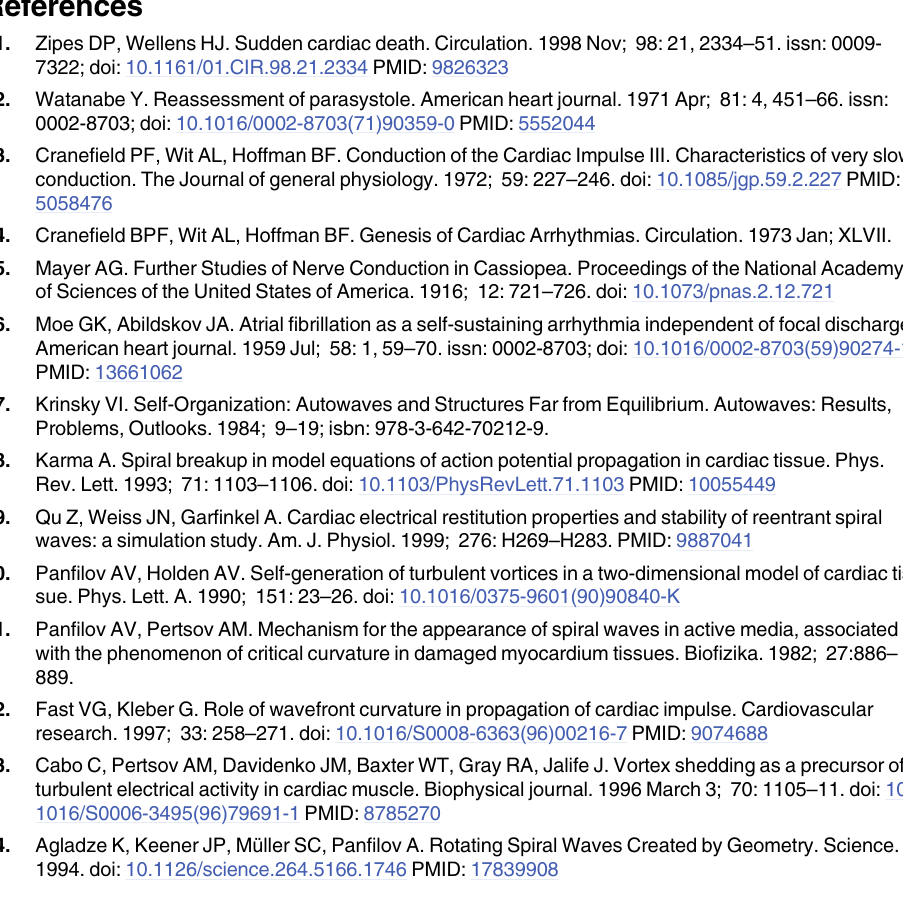
con- o T pass and block ), that constrain